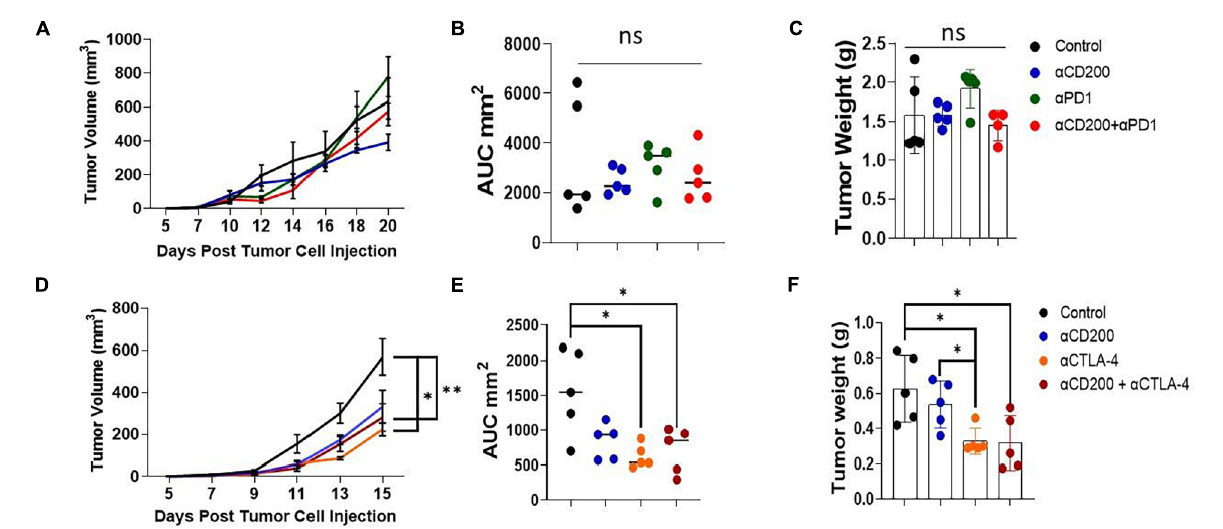
FIGURE 6 | Anti-CD200 therapy failed to show synergy with checkpoint inhibitors. Yumm1.7 cells were injected into each mouse s.c. at a dose of 5 × 10 5 /mouse. When tumors were palpable, mice ( n = 5/group) were treated with 250 µ g/mouse of anti-CD200 (OX-90), anti-PD-1 (RPM1-14) or α CTLA-4 (9H10) or vehicle i.p. every 3 days. Tumor growth was monitored by measuring tumor length and width every 2 days. (A–C) Anti-CD200 therapy failed to show synergy with anti-PD-1 therapy. Growth kinetics (A) , AUC (B) and tumor weight (C) are shown. Ns: not significant by one way ANOVA. (D–F) Anti-CD200 therapy failed to show synergy with anti-CTLA4 therapy. Growth kinetics ( D , ∗ P = 0.02; ∗∗ P = 0.005), AUC ( E , ∗ P = 0.011, control vs. aCTLA4; ∗ P = 0.026, control vs. aCD200/CTLA4) and tumor weight ( F , ∗ P = 0.0115, control vs. aCTLA4; ∗ P = 0.023, control vs. aCD200/CTLA4; ∗ P = 0.015, aCD200 vs. aCTLA4) are shown. Data shown represents two to three experiments with similar results. One way ANOVA was used for the